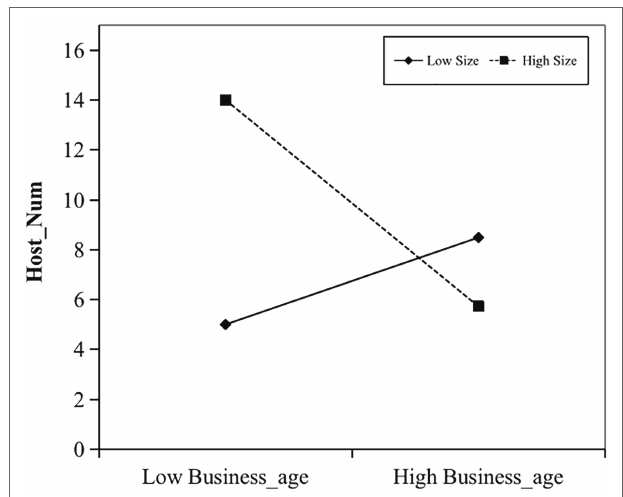
FIGURE 1 | Interaction of business age and size on host performance.